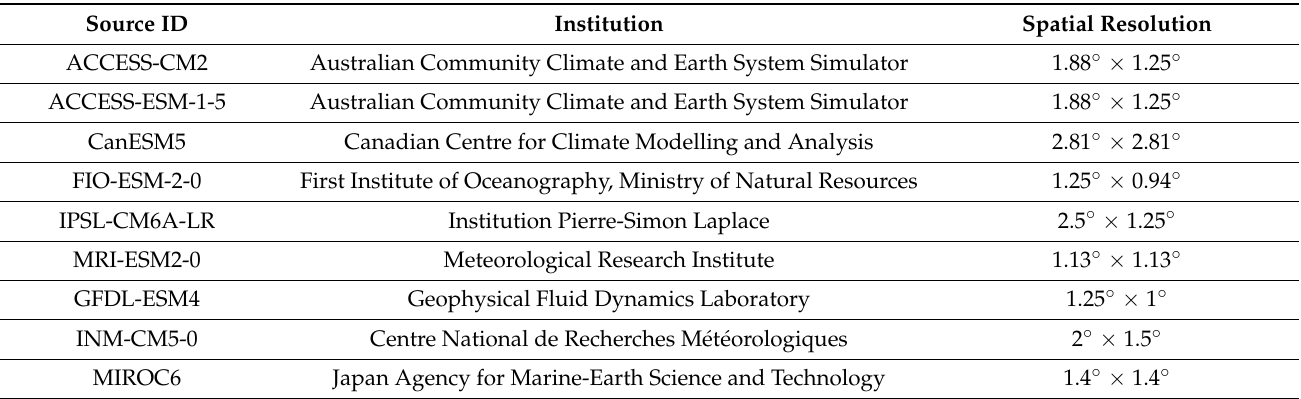
Table 1. Information of nine global climate models